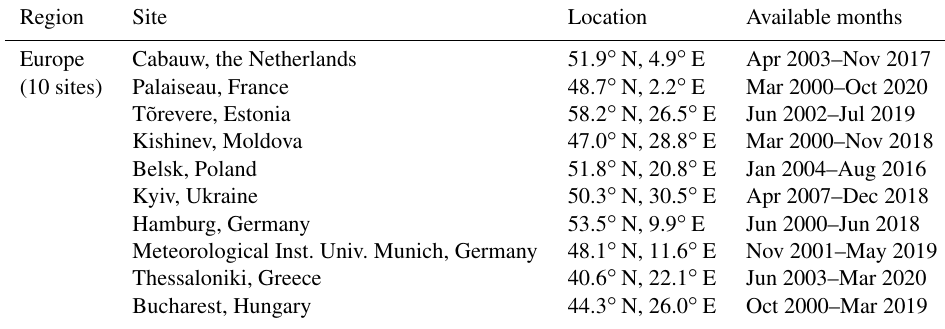
Table A2. Surface irradiance validation sites (land).